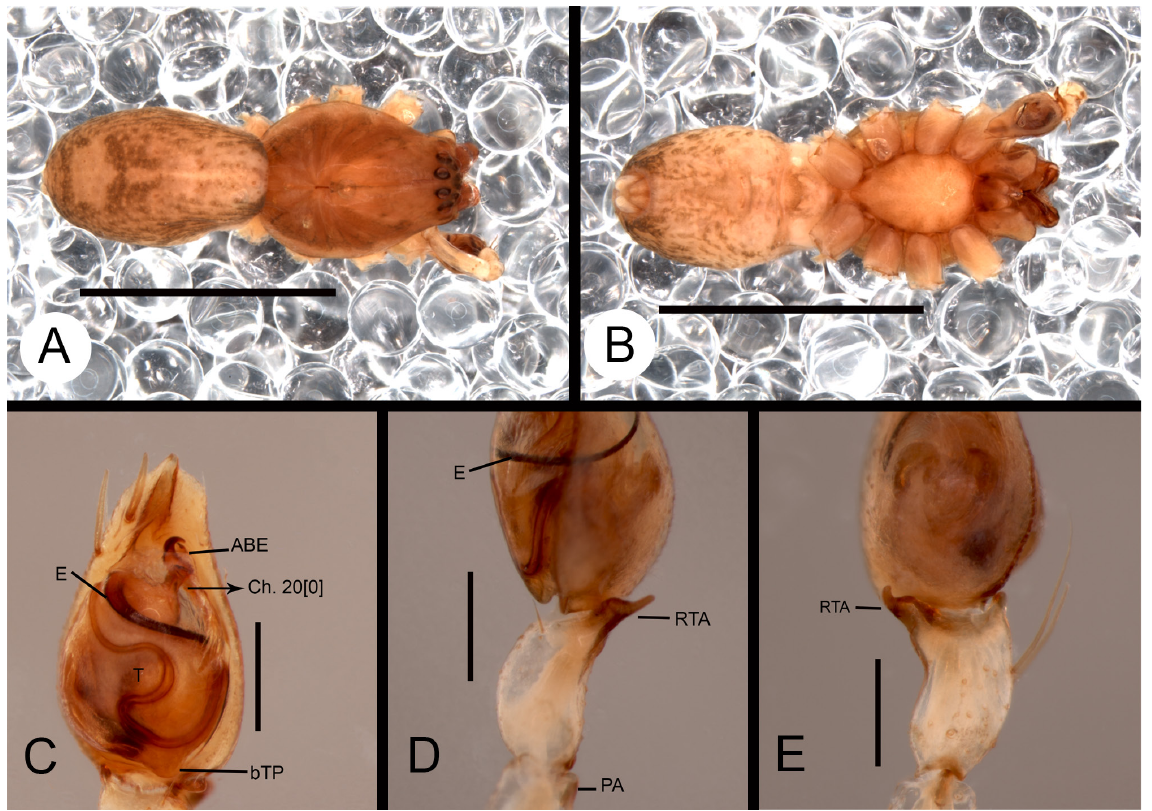
Fig. 24. Tafana chimire sp. nov. (MACN-Ar), ♂. A . Habitus, dorsal view. B . Habitus, ventral view. C . Left palp, ventral view (arrow indicating character). D . Left palp, retrolateral view. E . Left palp, dorsal view. Abbreviations: ABE = apophysis of base of the embolus; bTP = basal tegular protuberance; Ch = character; E = embolus; PA = patellar apophysis; RTA = retrolateral tibial apophysis; T = tegulum. Scale bars: A–B = 2.16 mm; C–E = 0.25